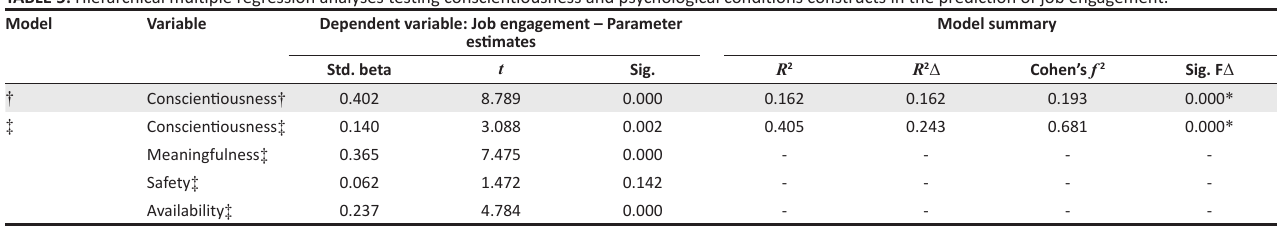
TABLE 5 : Hierarchical multiple regression analyses testing conscientiousness and psychological conditions constructs in the prediction of job engagement. Model